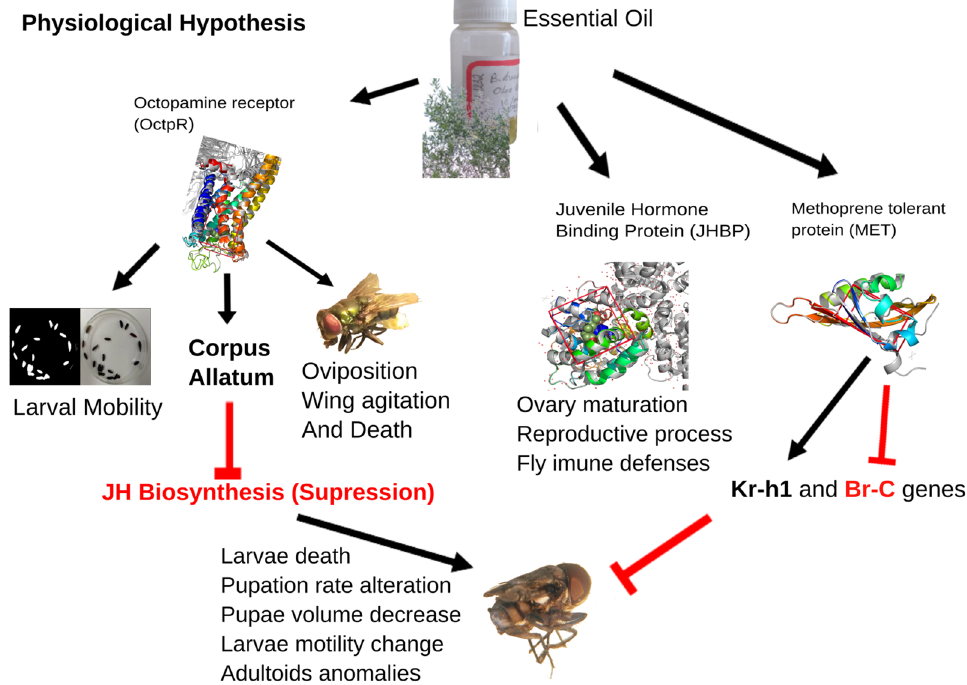
Figure 8. The physiological hypothesis of essential oils’ action on blowfly metabolism. Diagram based on the computational and experimental results. Black arrow point induction and red line